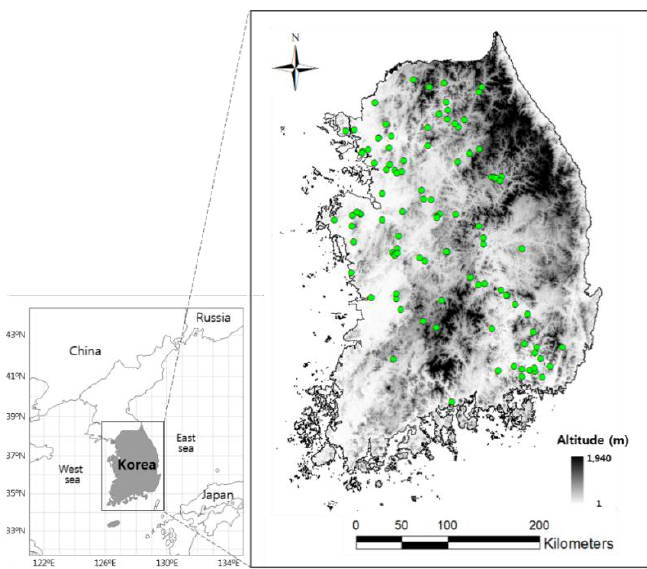
Figure 1. Occurrence (presence) sites of Metcalfa pruinosa based on the literature [23,27,47]